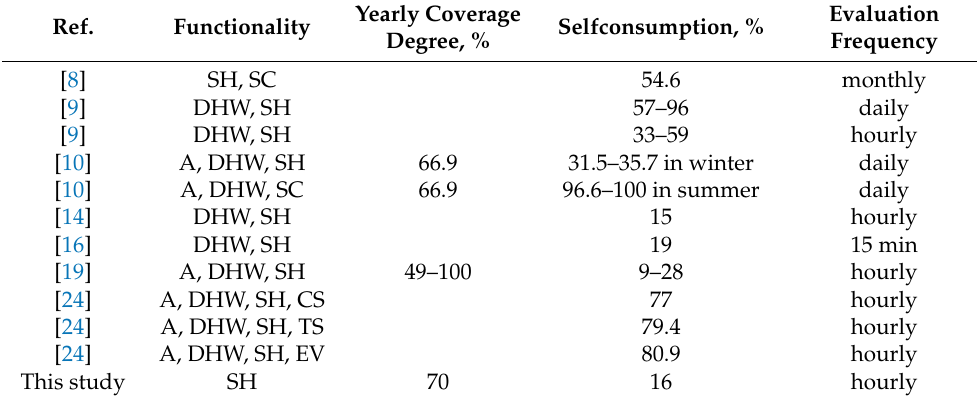
Table 8. Synthesis of the results of similar studies found in literature. Ref.